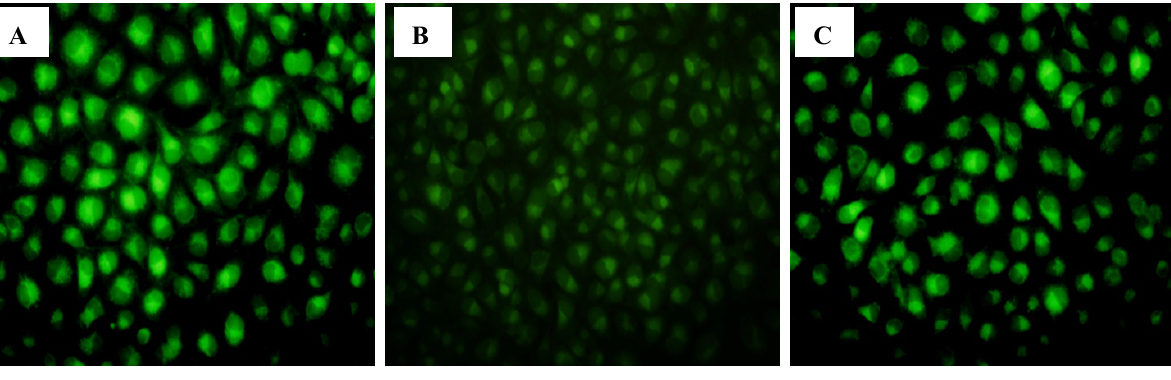
Figure 7. Fluogram of various breast cancer cell line stained by Rhodamine 123 (×400). ( A ): MCF7; ( B ): MCF7/ADM; ( C ): MCF7/ADM after